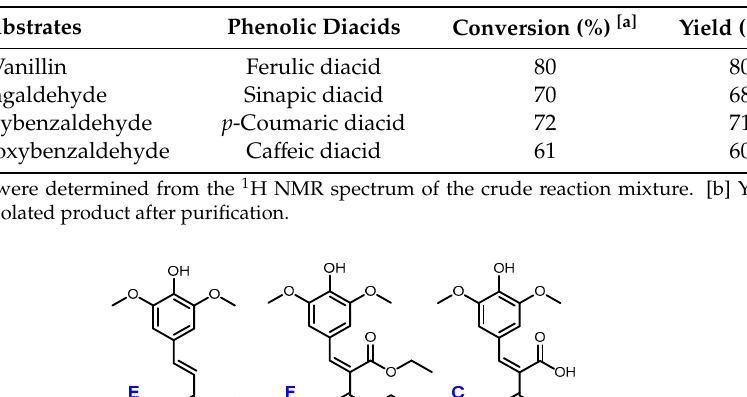
Figure 4. Structures of coumaric diacid ( A ), ferulic diacid ( B ), sinapic diacid ( C ) and caffeic diacid ( D ). Table 5. Conversion rate and isolated yields of p -hydroxycinnamic diacids.